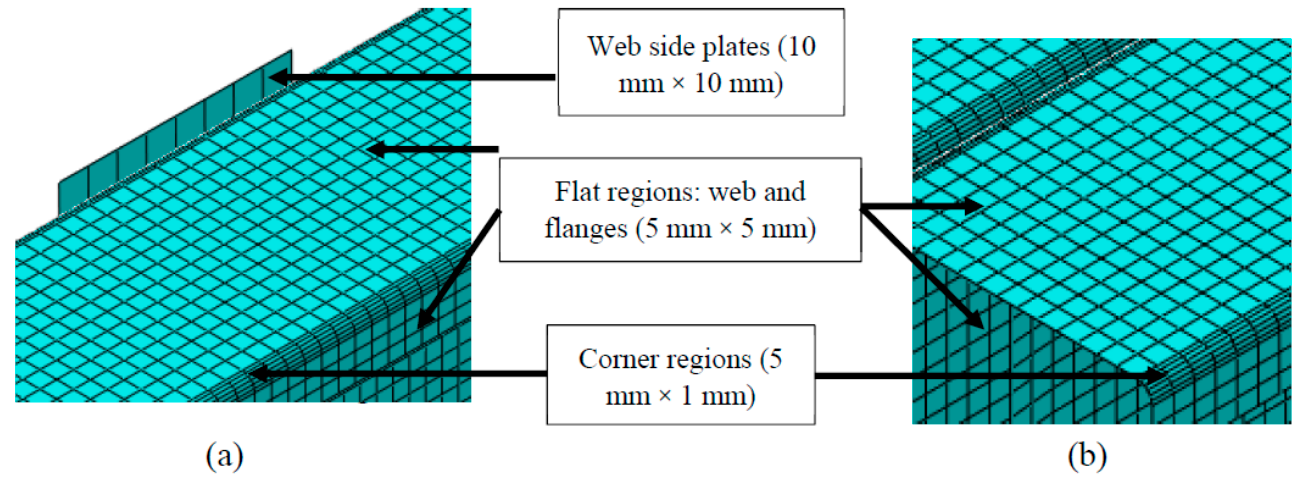
Figure 3. Meshing scheme ( a ) Single sections and ( b ) Built-up sections.